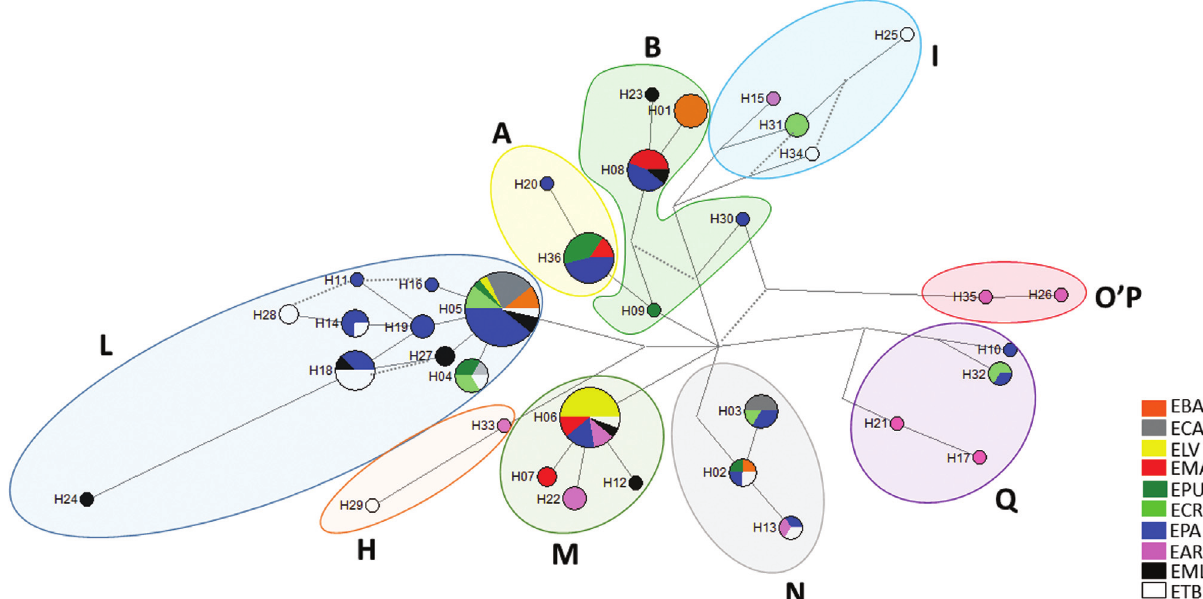
Figure 2 - Median-joining network analysis of 36 haplotypes from 141 Brazilian horse mitochondrial DNA. Circles represent the haplotypes, and their sizes are proportional to the frequency. Colored shapes represent haplogroup classification according to Achilli et al. (2012). Horse Breeds: ELV - Lavradeira; EPU - Puruca; EMA - Marajoara; EBA - Baixadeira; EPA - Pantaneira; ECR - Crioula; EML - Manga Larga; ECA - Campeira; EAR - Árabe; ETB - English